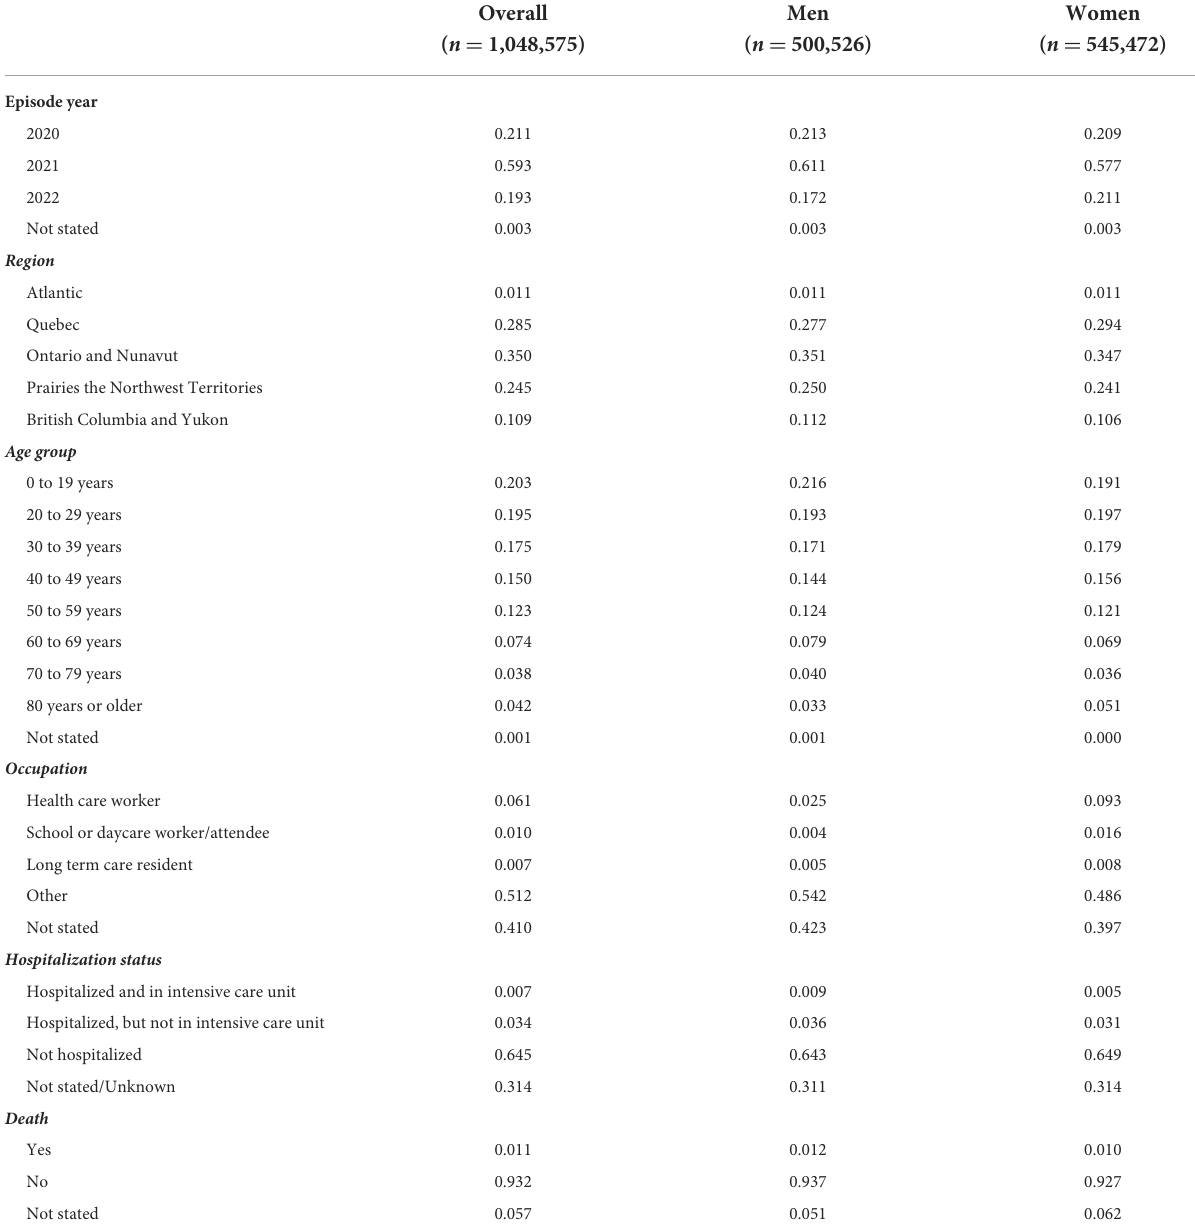
TABLE 1 Summary statistics of key variables in analysis overall and by gender